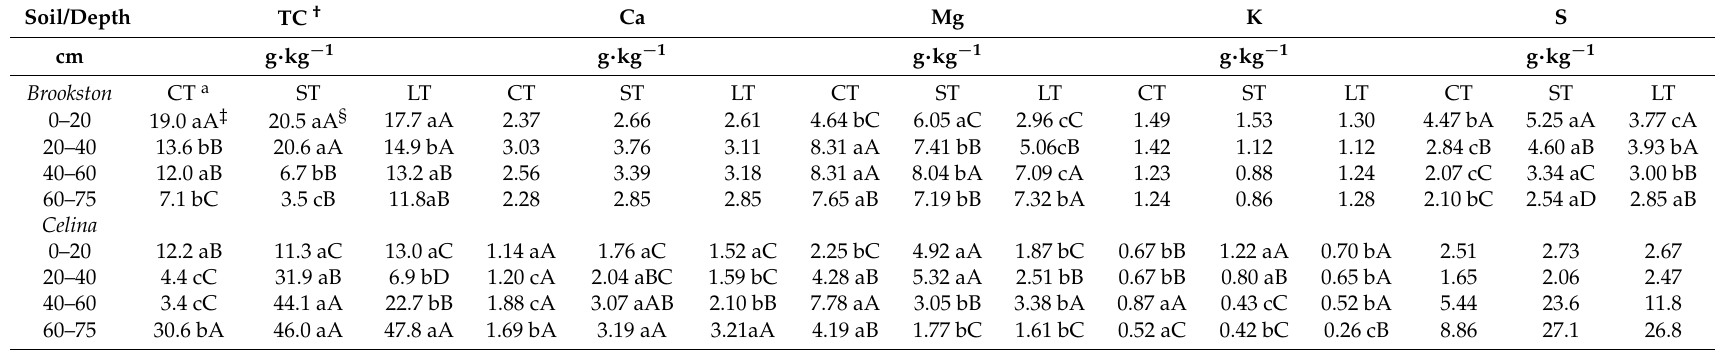
Table 2. Total (C) and macronutrients (Ca, Mg, K and S) in two Ohio soil profiles receiving three levels of gypsum.